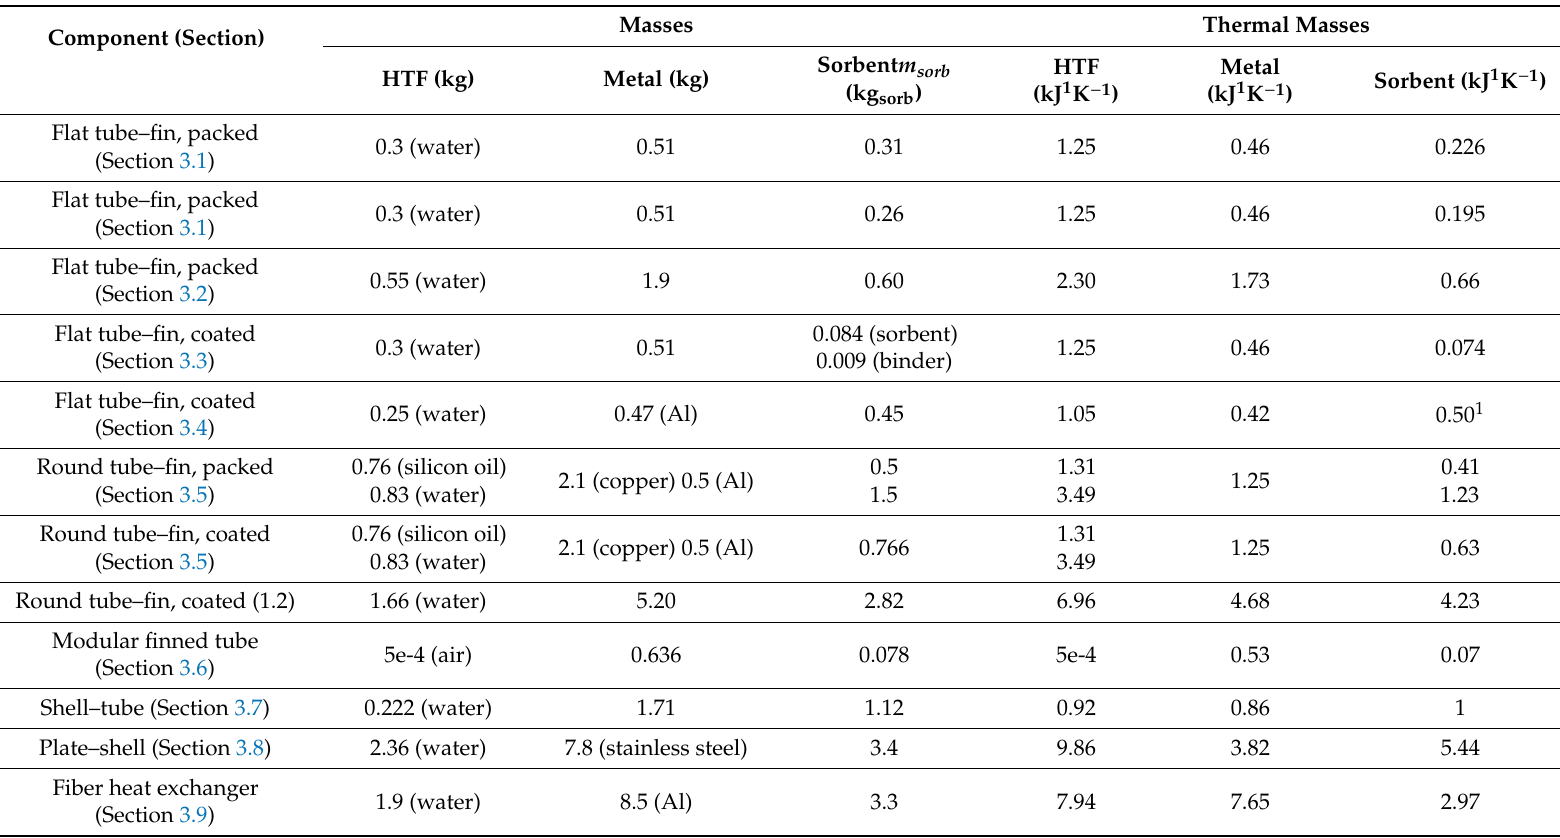
Table 5. Details of measured masses and thermal masses, excluding shells and enclosures for HX-only control volume of adsorber heat